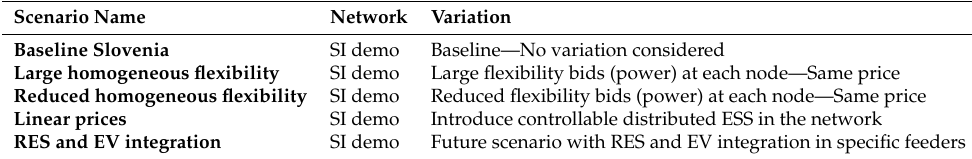
Table 12. Overview of the scenarios for Cluster